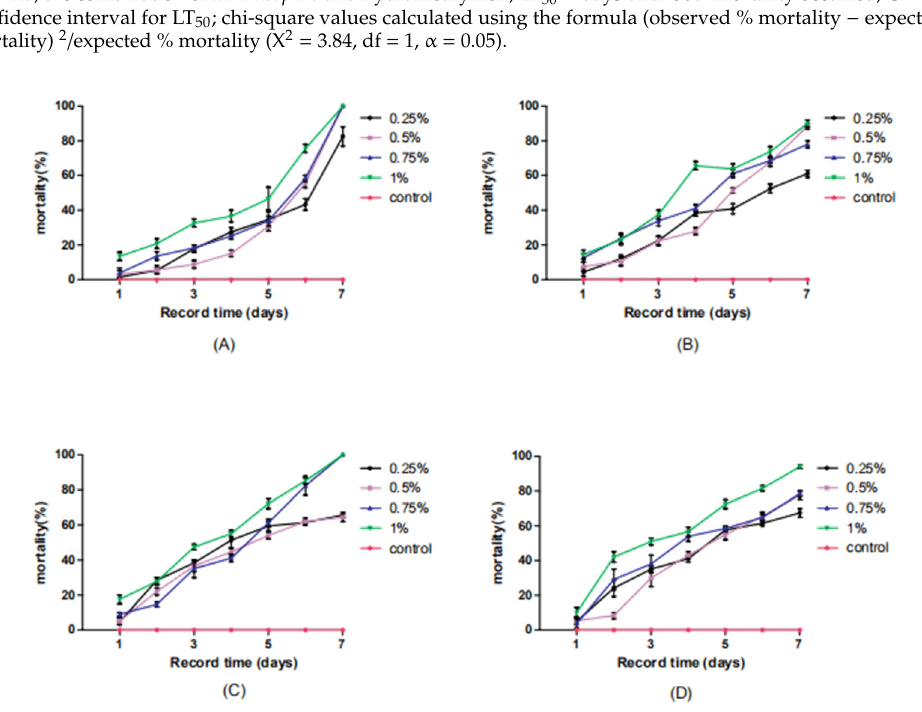
Figure 2. The cumulative mortality of B. germanica infected with M. anisopliae and hydramethylnon at different concentrations in baits at 7 days postinoculation under laboratory conditions. ( A ) 1 × 10 5 cfu/mL M. anisopliae and 0.25%, 0.5%, 0.75% or 1% hydramethylnon ( B ) 1 × 10 6 cfu/mL M. anisopliae and 0.25%, 0.5%, 0.75% or 1% hydramethylnon ( C ) 1 × 10 7 cfu/mL M. anisopliae and 0.25%, 0.5%, 0.75% or 1% hydramethylnon ( D ) 1 × 10 8 cfu/mL M. anisopliae and 0.25%, 0.5%, 0.75% or 1% hydramethylnon.